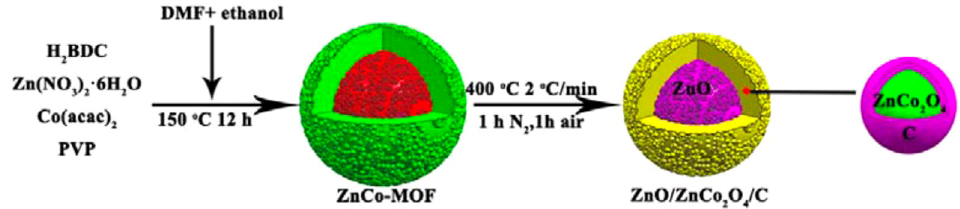
Figure 6. Scheme of preparation of ZnO/ZnCo 2 O 4 /C composite. Reprinted with permission from [28]. Copyright 2015, American Chemical Society.